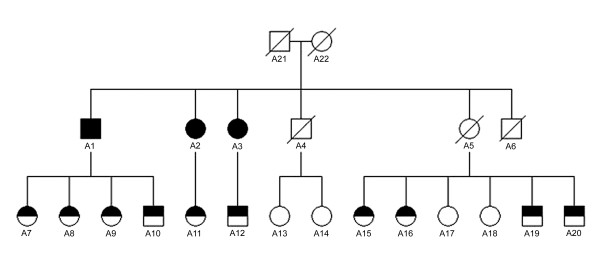
Pedigree of family A. Fully shaded squares (men) and circles (women) denote homozygous c.2447G>A (p.R722H) mutations in the POLG1 gene and half-shaded symbols heterozygosity.